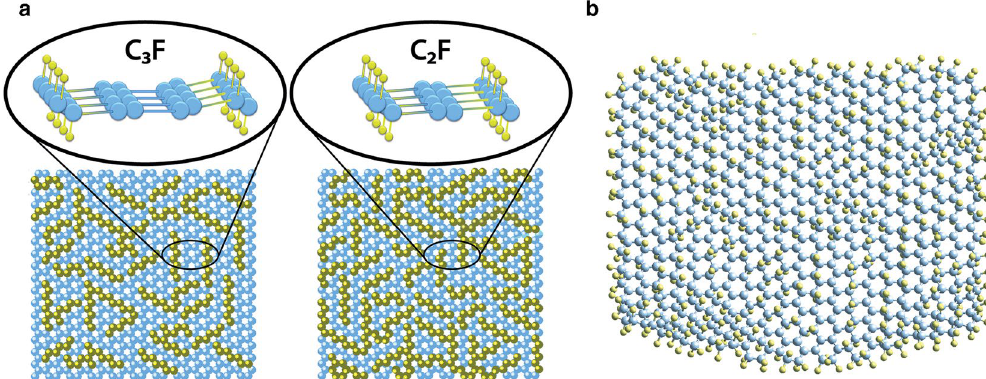
Figure 1. Basal plane of deficiently fluorinated graphene: ( a ) Embedded nanoribbons; ( b ) Tabby pattern is plotted according to the results of spectroscopic investigations 7,28,29 . The blue circles denote carbon atoms, and the yellow circles denote fluorine